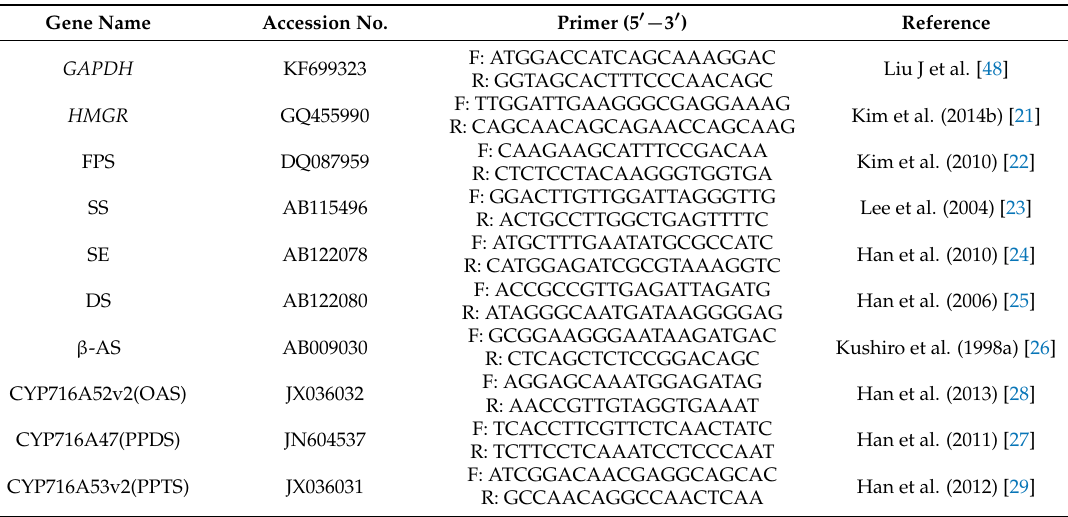
Table 14. Sequences of primers for real-time